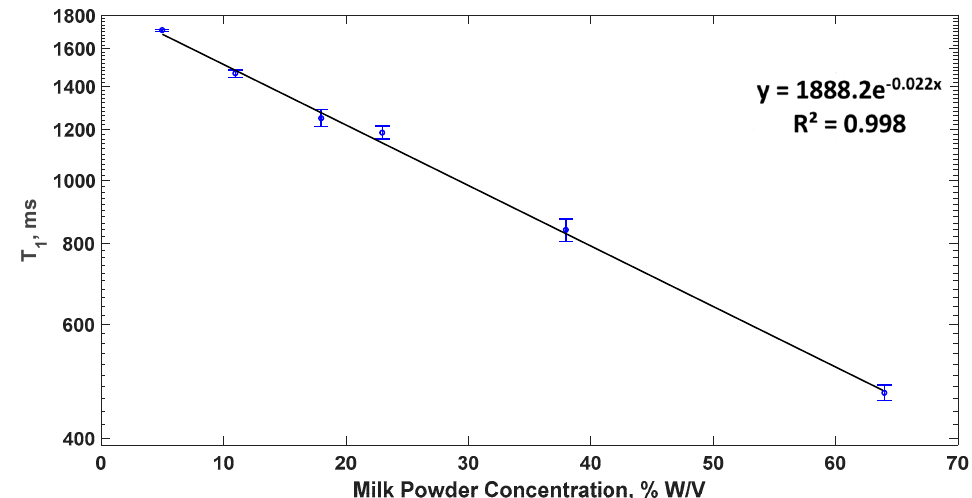
Figure 3. Spin lattice relaxation time T 1 values against full fat milk powder concentration measured using clinical MRI using the spine matrix coil.